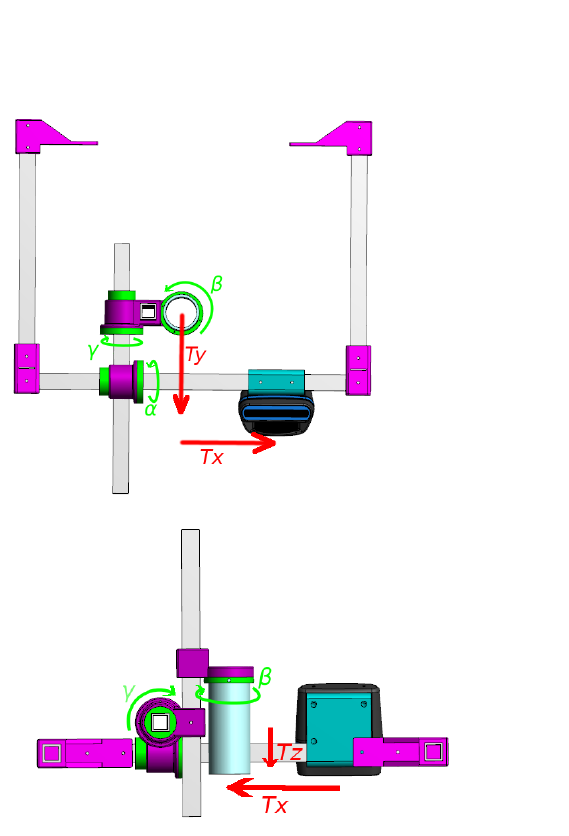
Figure 12. Representation of the extrinsic parameters as part of the frame used to set them during the experiments at sea. It is important to note that the rotations are expressed along the sonar frame R s while the translations are expressed along the optical camera frame R o , as defined in Figure